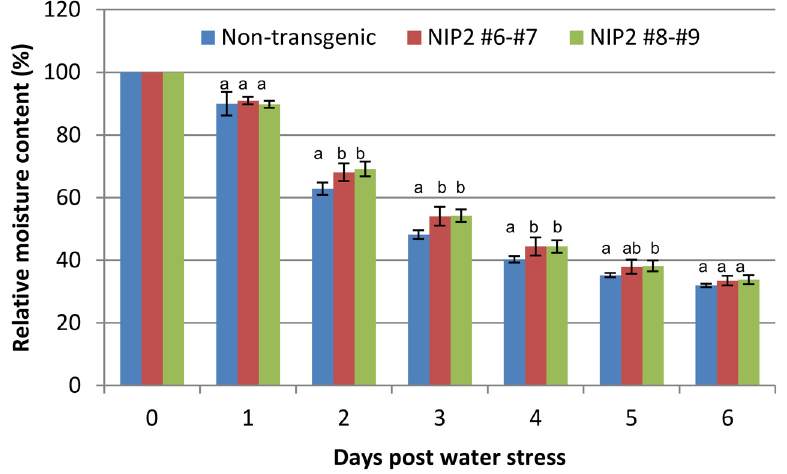
Fig 6. Water stress test on SspNIP2 transgenic lines. Relative moisture content (%) retained in each potted plant was measured during the first six days of water stress. The designation of transgenic lines are the same as shown in Fig 5. NIP2 #6-#7 and #8-#9 indicated that SspNIP2 transgenic lines #6 and #7, and lines #8 and #9 were combined, respectively, for the analysis. Statistical analysis was conducted by F-test followed by